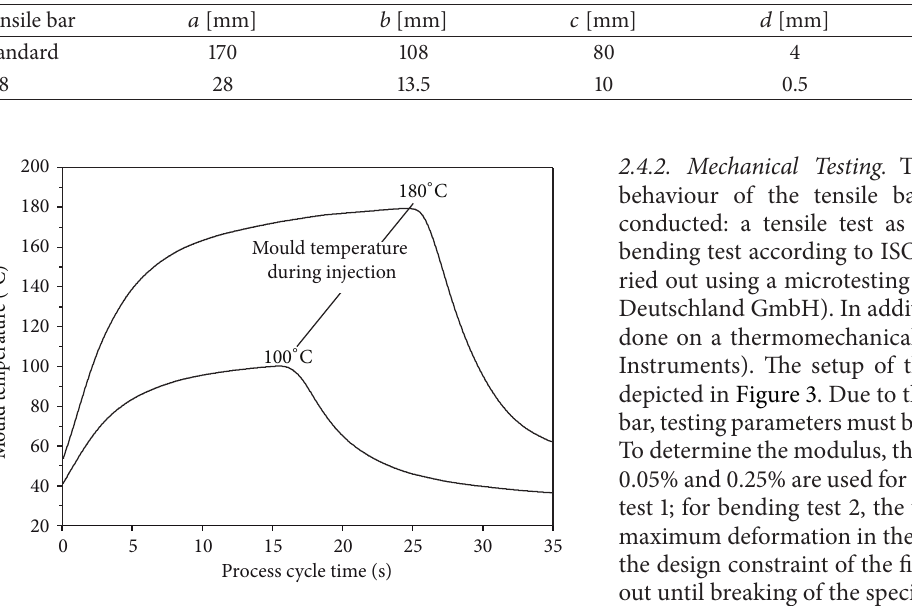
Figure2:Mouldtemperaturesduringinjectionmouldingtoachieve varied morphology in the specimens (close-to-cavity measure-